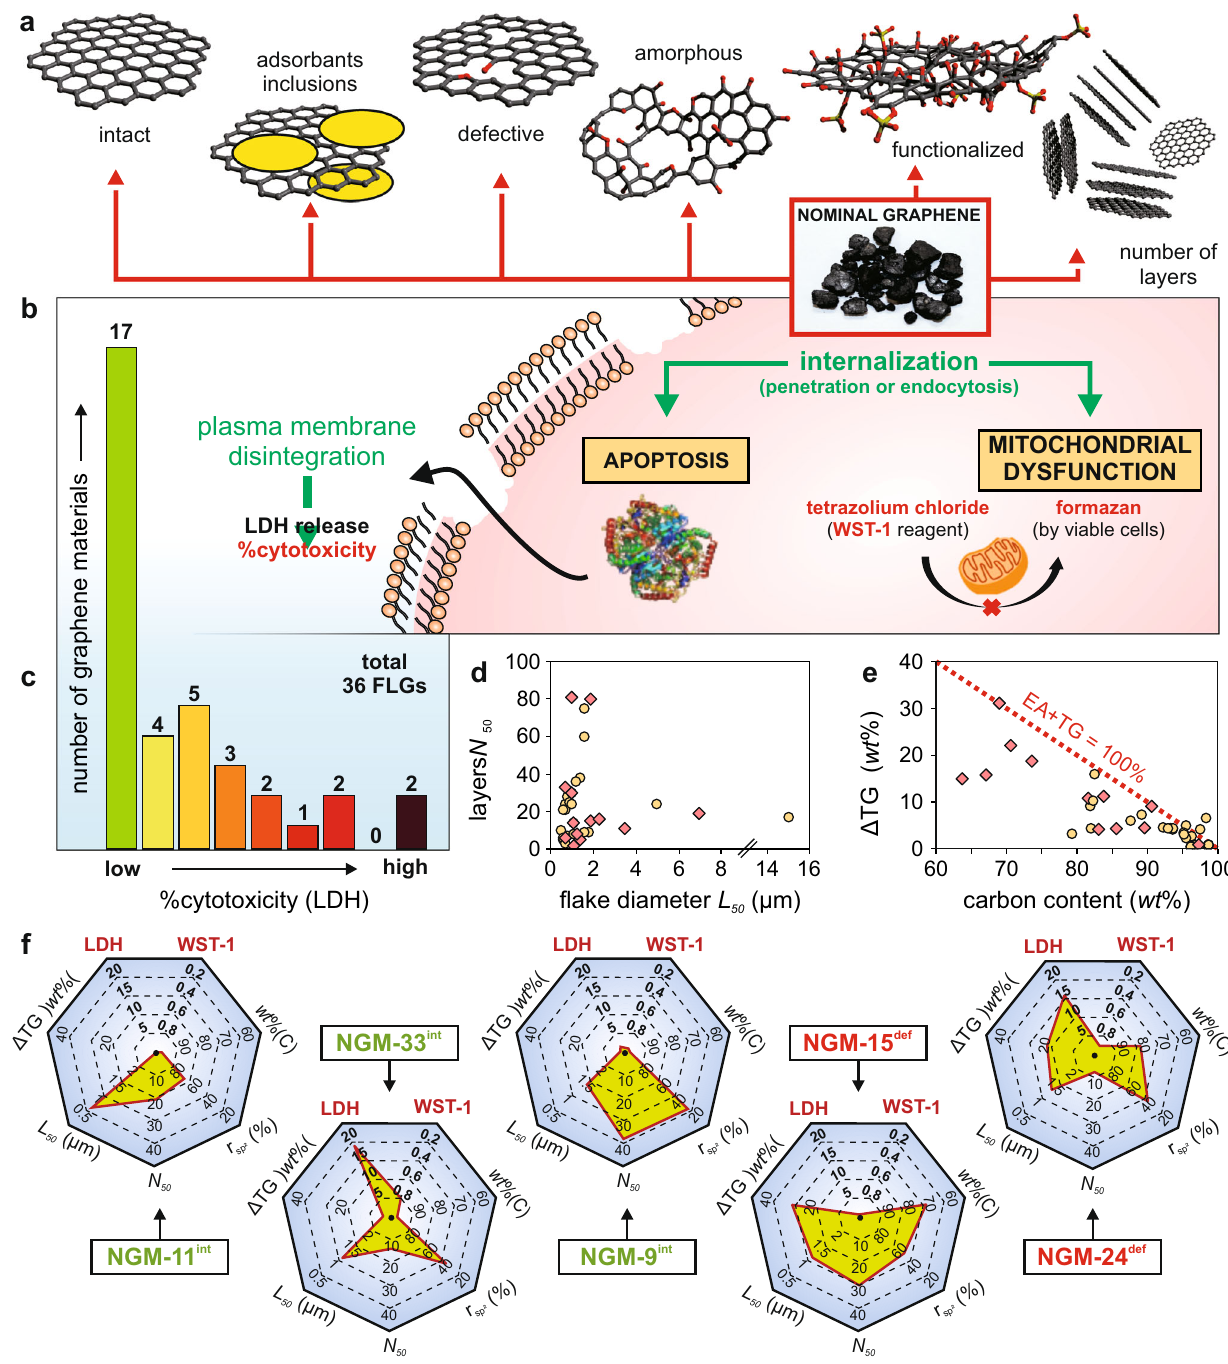
Fig. 1 Overview of possible components of nominal graphene materials (NGMs). a From left to right: graphene with and without in-plane defects; adsorbates and inclusions (yellow circles); slightly defective graphene and graphene dominated by extensive defects like holes or oxo-functional groups; highly functionalized graphene oxide; graphene with different number of layers. b Scheme of the internalization of graphene samples by cells and potential toxic outcomes measured by WST-1 and LDH. c Distribution of cytotoxicity measured by LDH release. d Median fl ake diameter L 50 vs. median number of layers N 50 . e Proportion of carbon content, wt %( C ), measured by elemental analysis, vs. thermogravimetric mass loss Δ TG in the range from 100 °C to 800 °C. The dashed red line represents the 100% line of the sum of carbon content wt %( C ) and mass loss. Intact graphene ( NGM int. ) is represented by yellow circles, defective graphene ( NGM def ) by red diamonds in both diagrams. f Illustration of performance heptagrams for fi ve different NGMs, representing their physiochemical properties and toxicity. Samples NGM-11 int , NGM-33 int , and NGM-9 int are high graphitic samples of good quality but have different toxicity pro fi le. NGM-15 def and NGM-24 def are very disordered, otherwise very similar, but one is toxic while the other is